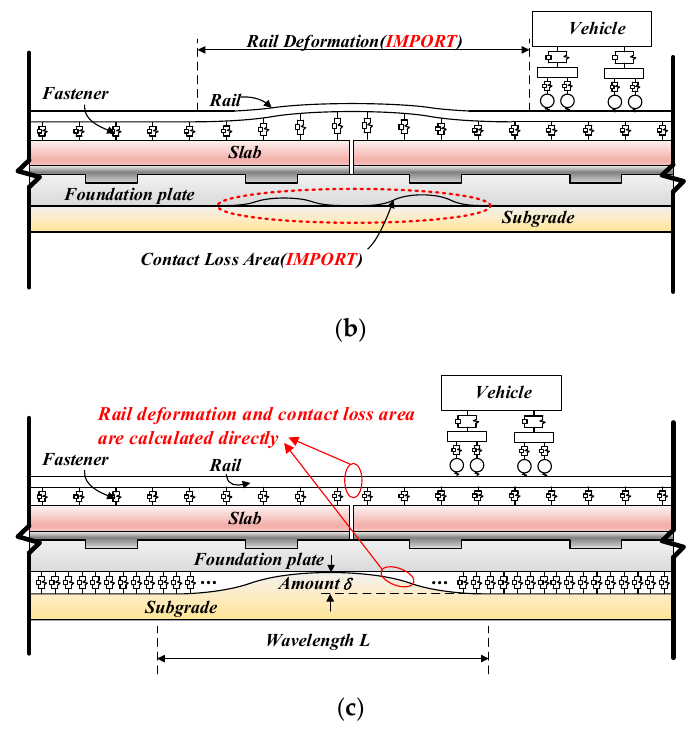
Figure 5. Theoretical topology models of different simulation methods of subgrade frost heave. ( a ) Theoretical model of Model-A; ( b ) Theoretical model of Model-B; ( c ) Theoretical model of Model-C.